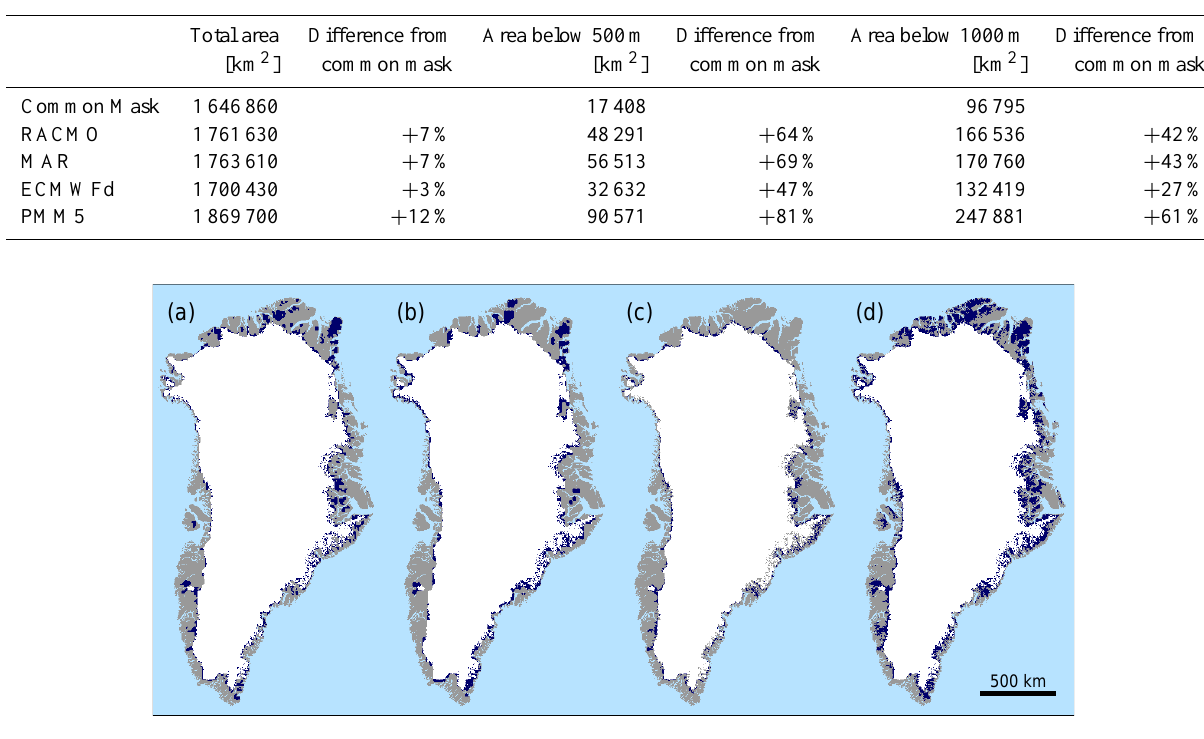
Table 1. Ice sheet mask area. Differences between each mask’s total area and the common mask are small, however, differences in the influential low elevation areas are significant.